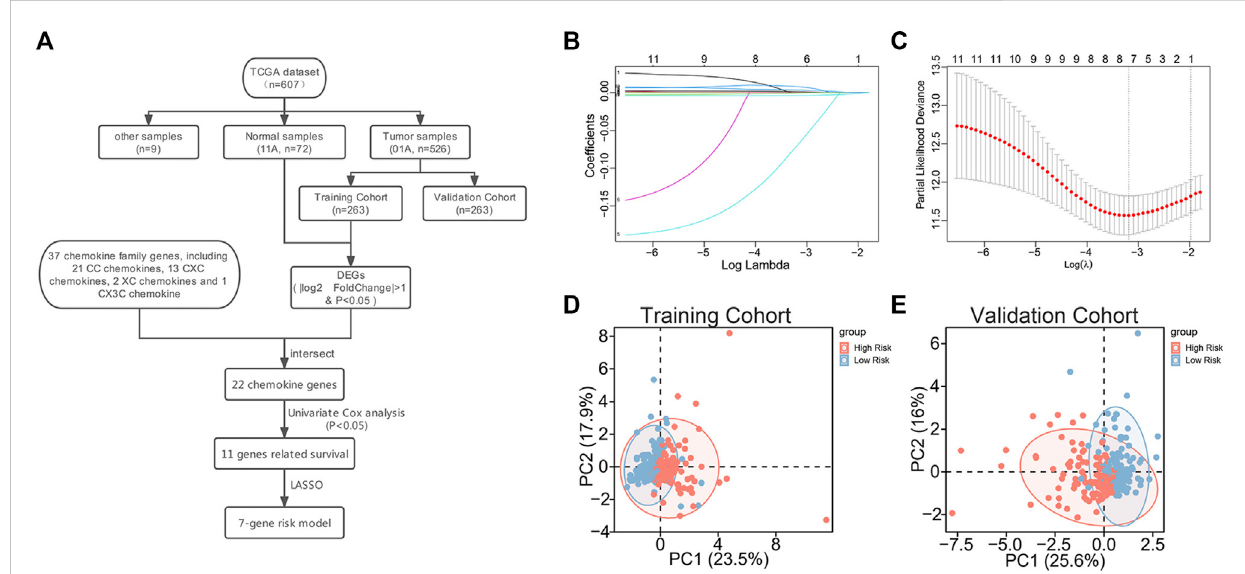
FIGURE 1 Construction of 7-chemokine-genes prognostic signature. (A) Flow chart of model construction. (B) Cross-validation was performed to optimize theparameterselectionoftheLASSOregressionmodel. (C) Distribution oflassocoef fi cientsof11prognosis-relatedchemokinegenes. (D,E) Correlation between chemokine genes signature and pro fi les of seven chemokine genes ’ expression in the training cohort and validation